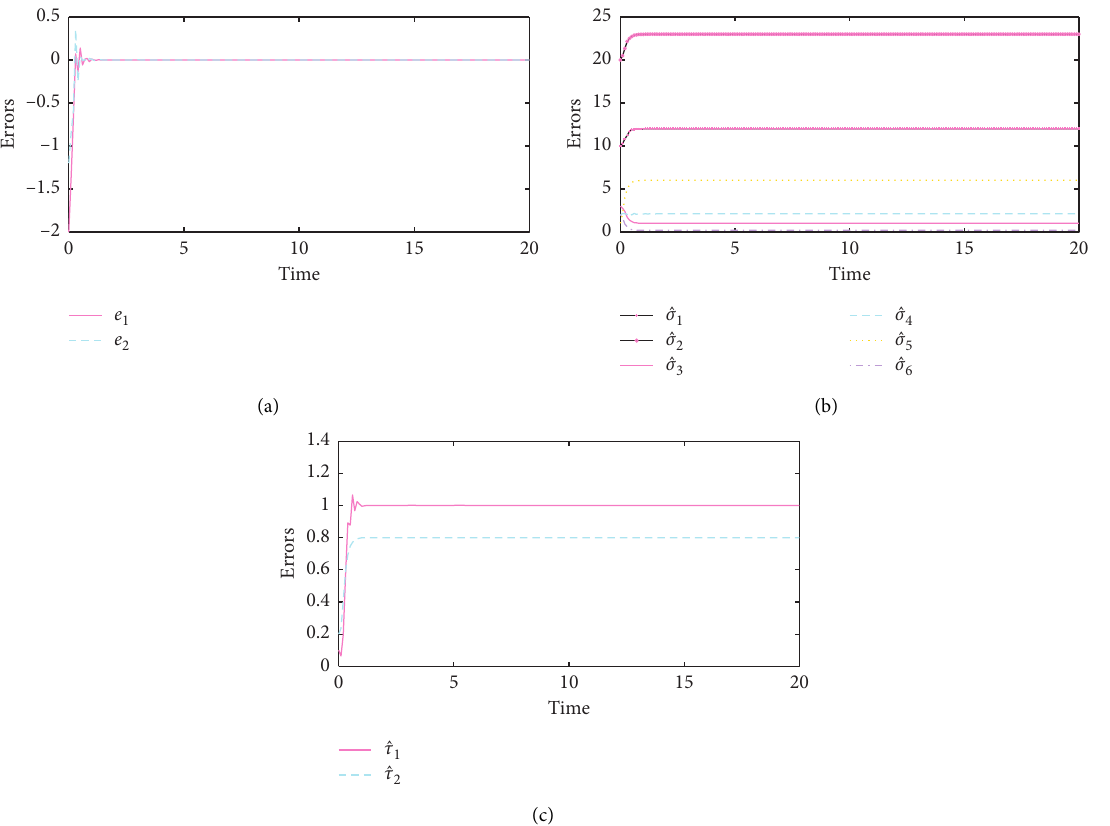
Figure 7: (a) Trajectories of the errors; (b) trajectories of the drive system unknown parameter estimates; (c) trajectories of the response system unknown parameter